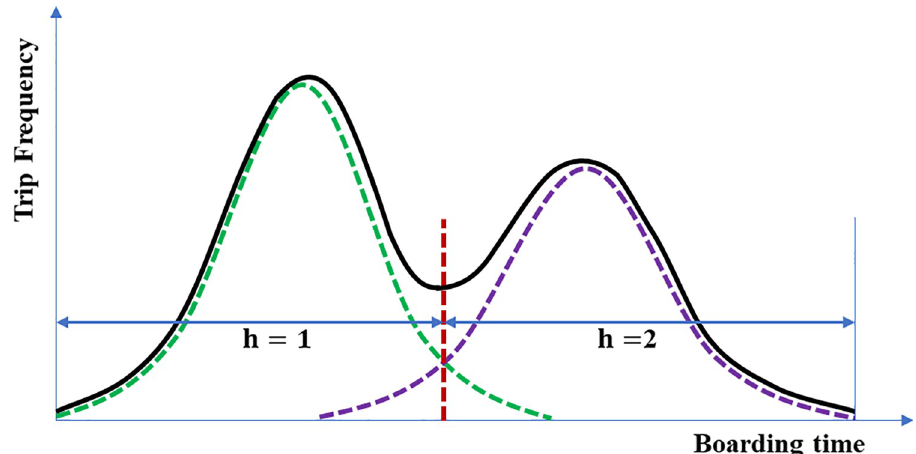
Fig 4. Example of a trip pattern consisting of a mixture of two Gaussians.